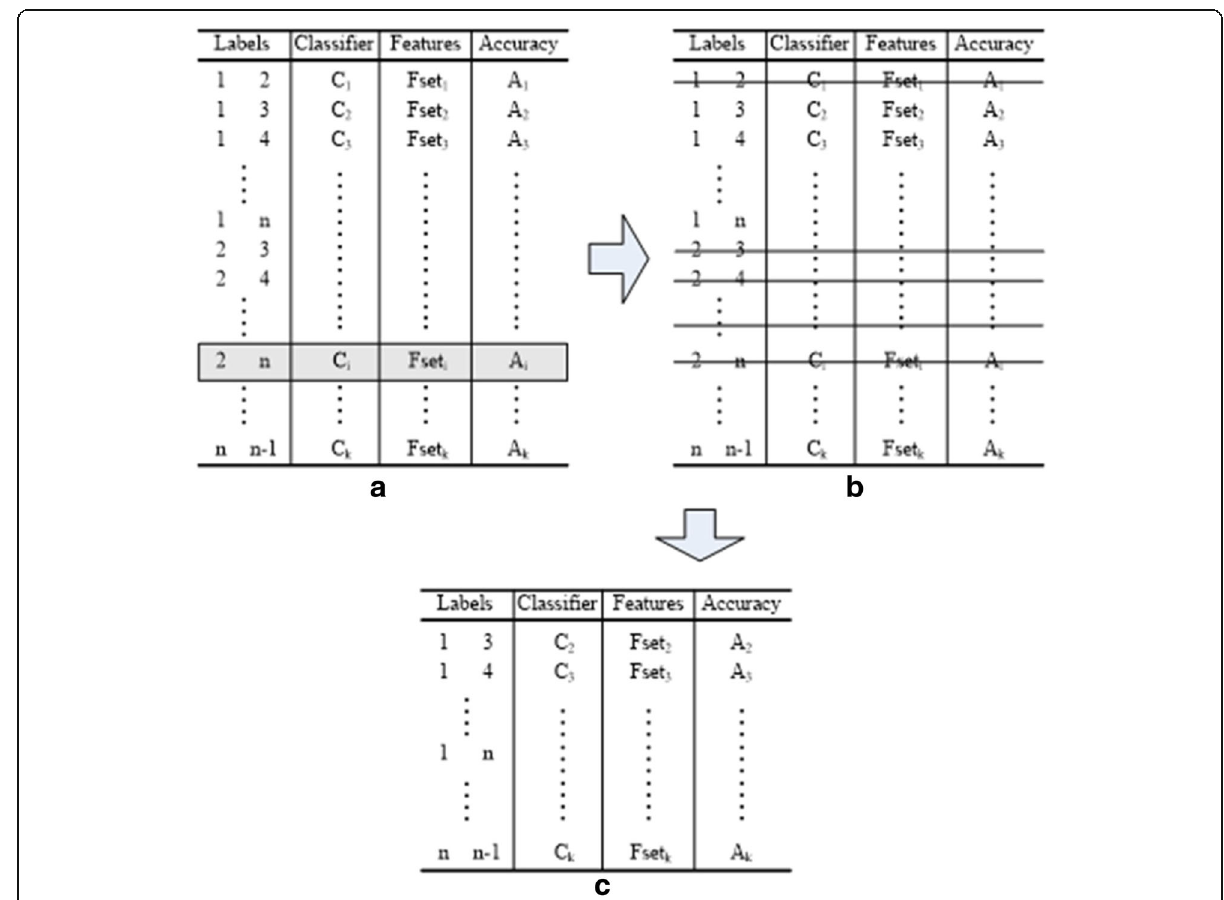
Fig. 1 Example of consequential eliminating process in LFA table. Figure 1 shows a process of CEP algorithm. Suppose A i is the maximum accuracy value in a . For the first layer, the classifier C i with the maximum accuracy is chosen. The testing sample is then classified by classifier C i with feature set Fset i between label 2 and label n . Suppose the result of the first layer is n . It is believed that the testing sample does not belong to label 2. Then, lines with label 2 are eliminated from the original LFA table as shown in b . For the second layer, the above processes are repeated again with the new LFA table shown in c and another label is eliminated from the new LFA table. The rest may be deduced by analogy. After n − 2 layers of classification, there will be only one line left in the LFA table. This last classifier gives the final predicted label of the testing